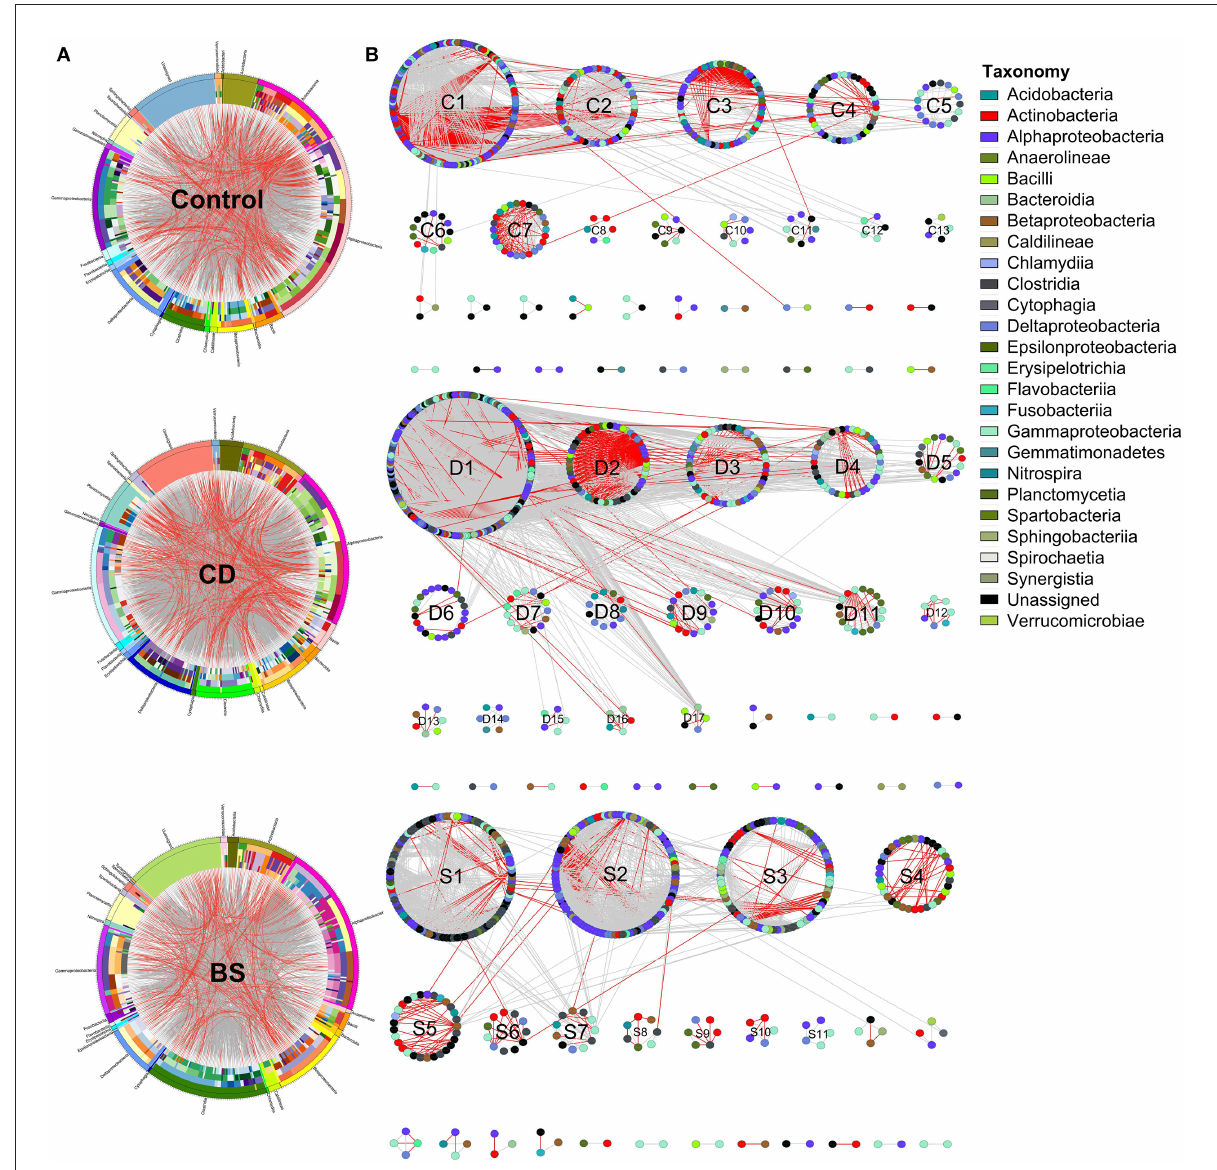
FIGURE5 Circular plot (A) and ecological network (B) descriptions of the interspecific interactions within bacterial community. The width of the bars represents the abundance of each taxon. The bands with different colors demonstrate the source of different genera. The taxonomic levels were class, order, family, genera, and species from the outside to the inside of the circle, respectively. Each node in network graph indicates one OTU. Colors of the nodes indicate different major classes. The edges (gray edge, positive interaction and red edge, negative interaction) inside the circle and ecological network represent the interactions between